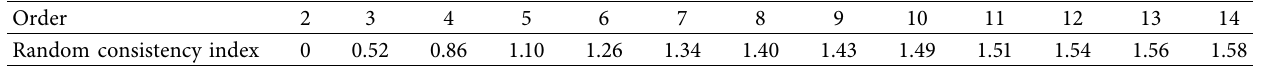
Table 2: The mean random consistency index [22, 23].